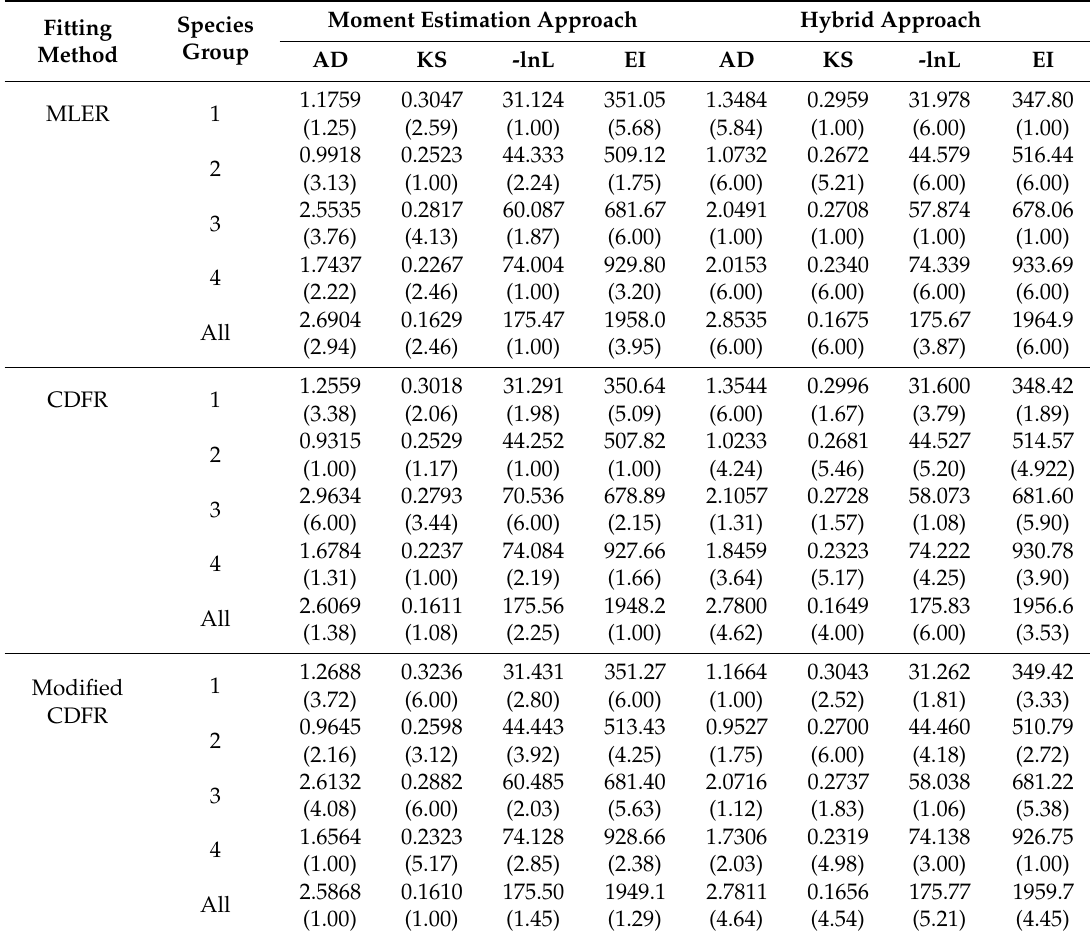
Table 4. Evaluation statistics (and relative ranks a ), by species code, prediction approach, and fitting